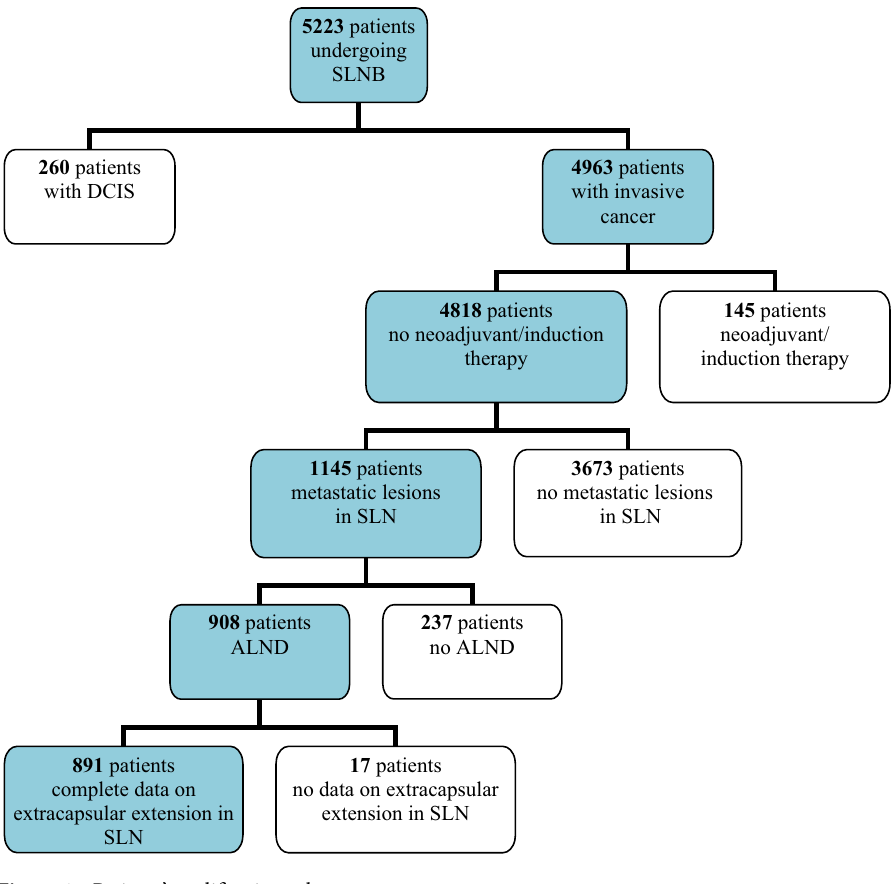
Figure 1. Patients’ qualification